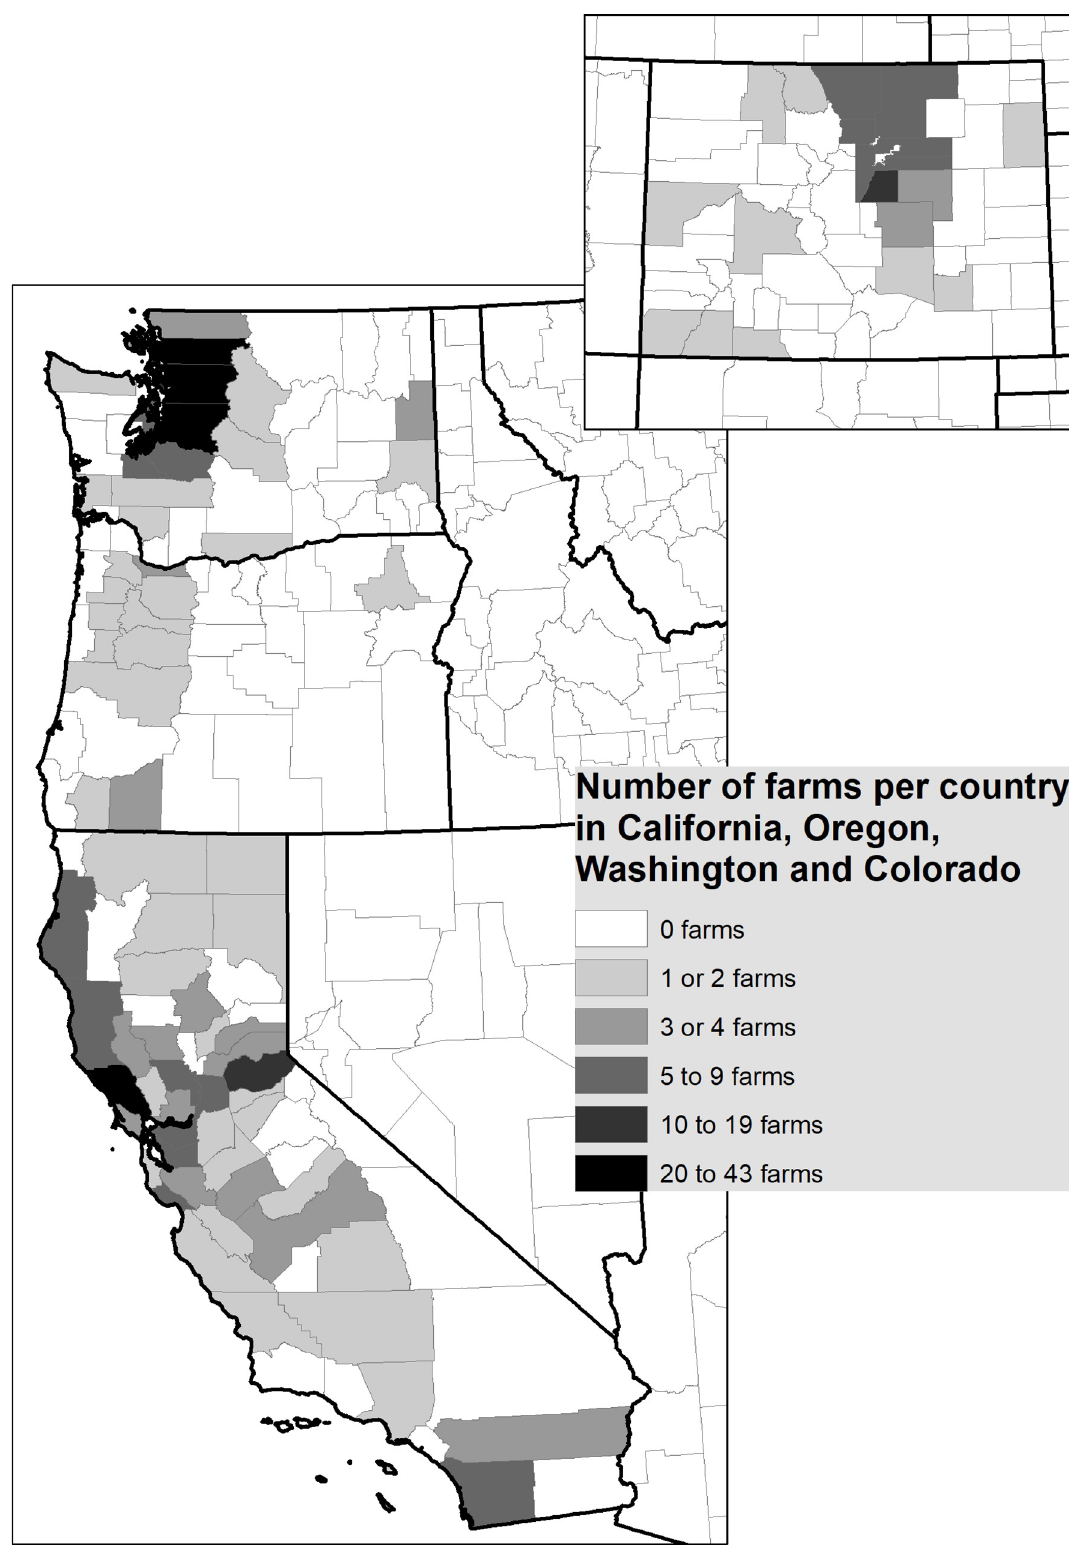
Fig 1. Distribution of animal owners (n = 417) surveyed by counties in 4 western states (Washington, Oregon, California and Colorado). https://doi.org/10.1371/journal.pone.0212372.g001 PLOS ONE | https://doi.org/10.1371/journal.pone.0212372 February 14,